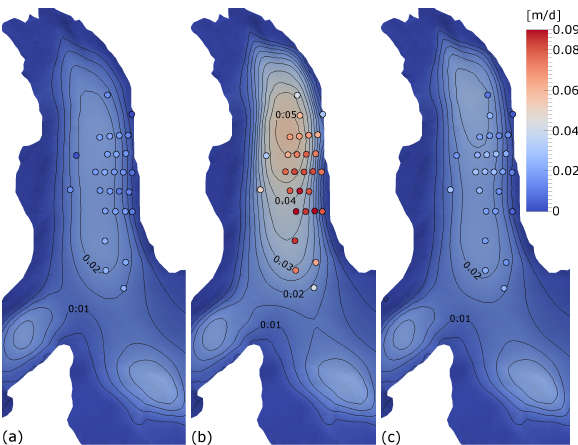
Fig. 14. Spatial pattern of modelled surface velocities on the tongue of Haut Glacier d’Arolla for the year 1993. Before the spring event (a) (days 182 to 185), during the speed-up (b) (days 186 to 188) and after the event (c) (days 188 to 190). The surface velocities are given by the colour scale inmd − 1 and contoured every 0 . 005md − 1 . The dots on the three panels present the measured velocities of the first 1998 speed-up event as documented in Mair et al. (2003) with the same colour scale as that of the model